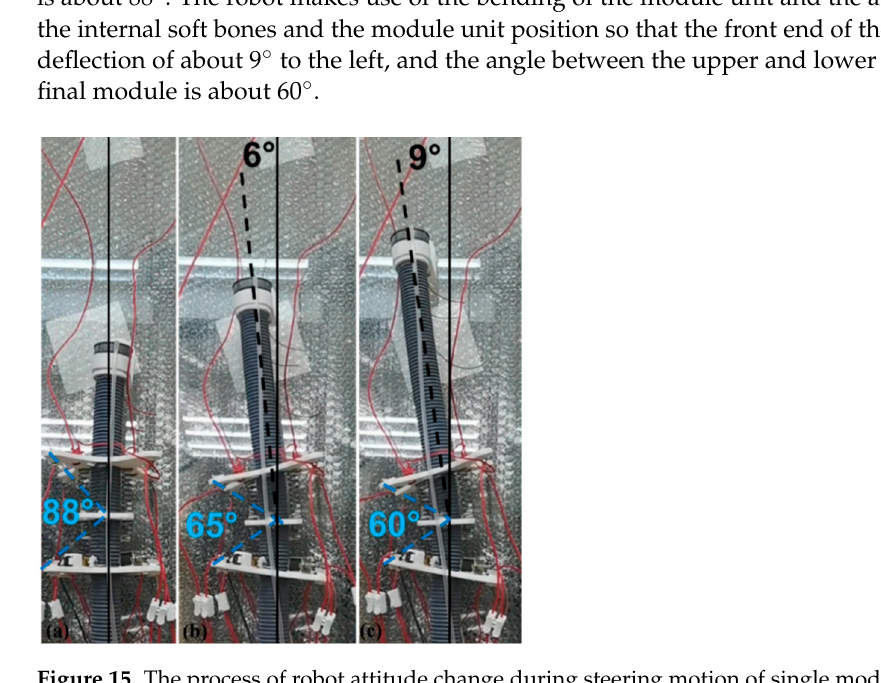
Figure 15. The process of robot attitude change during steering motion of single module prototype.